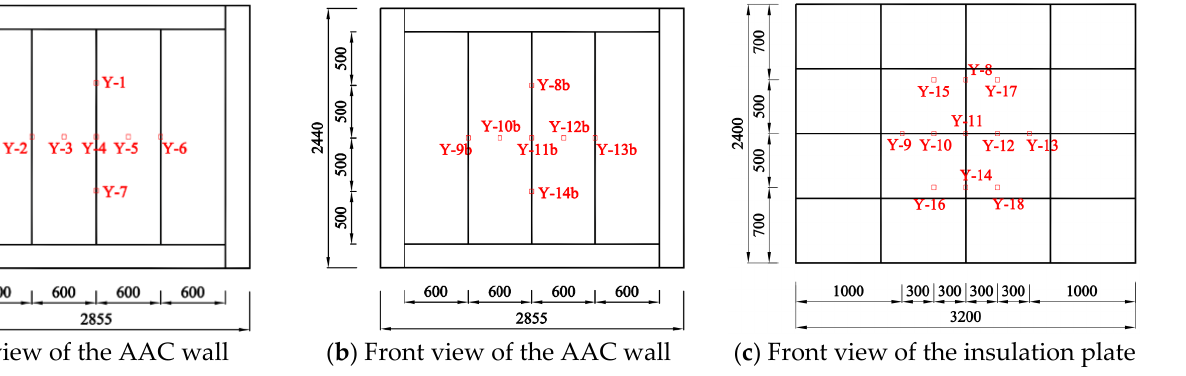
Figure 7. Arrangement of the gauges.